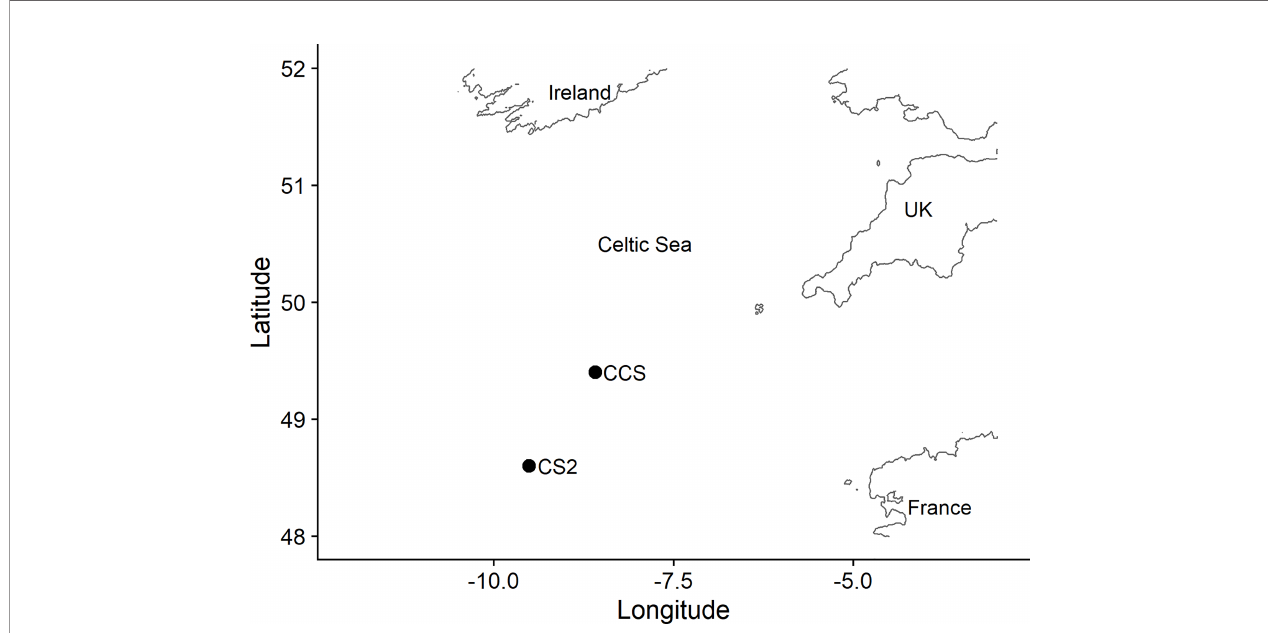
FIGURE 1 | Map of the study area showing the positions on the two stations in the Celtic